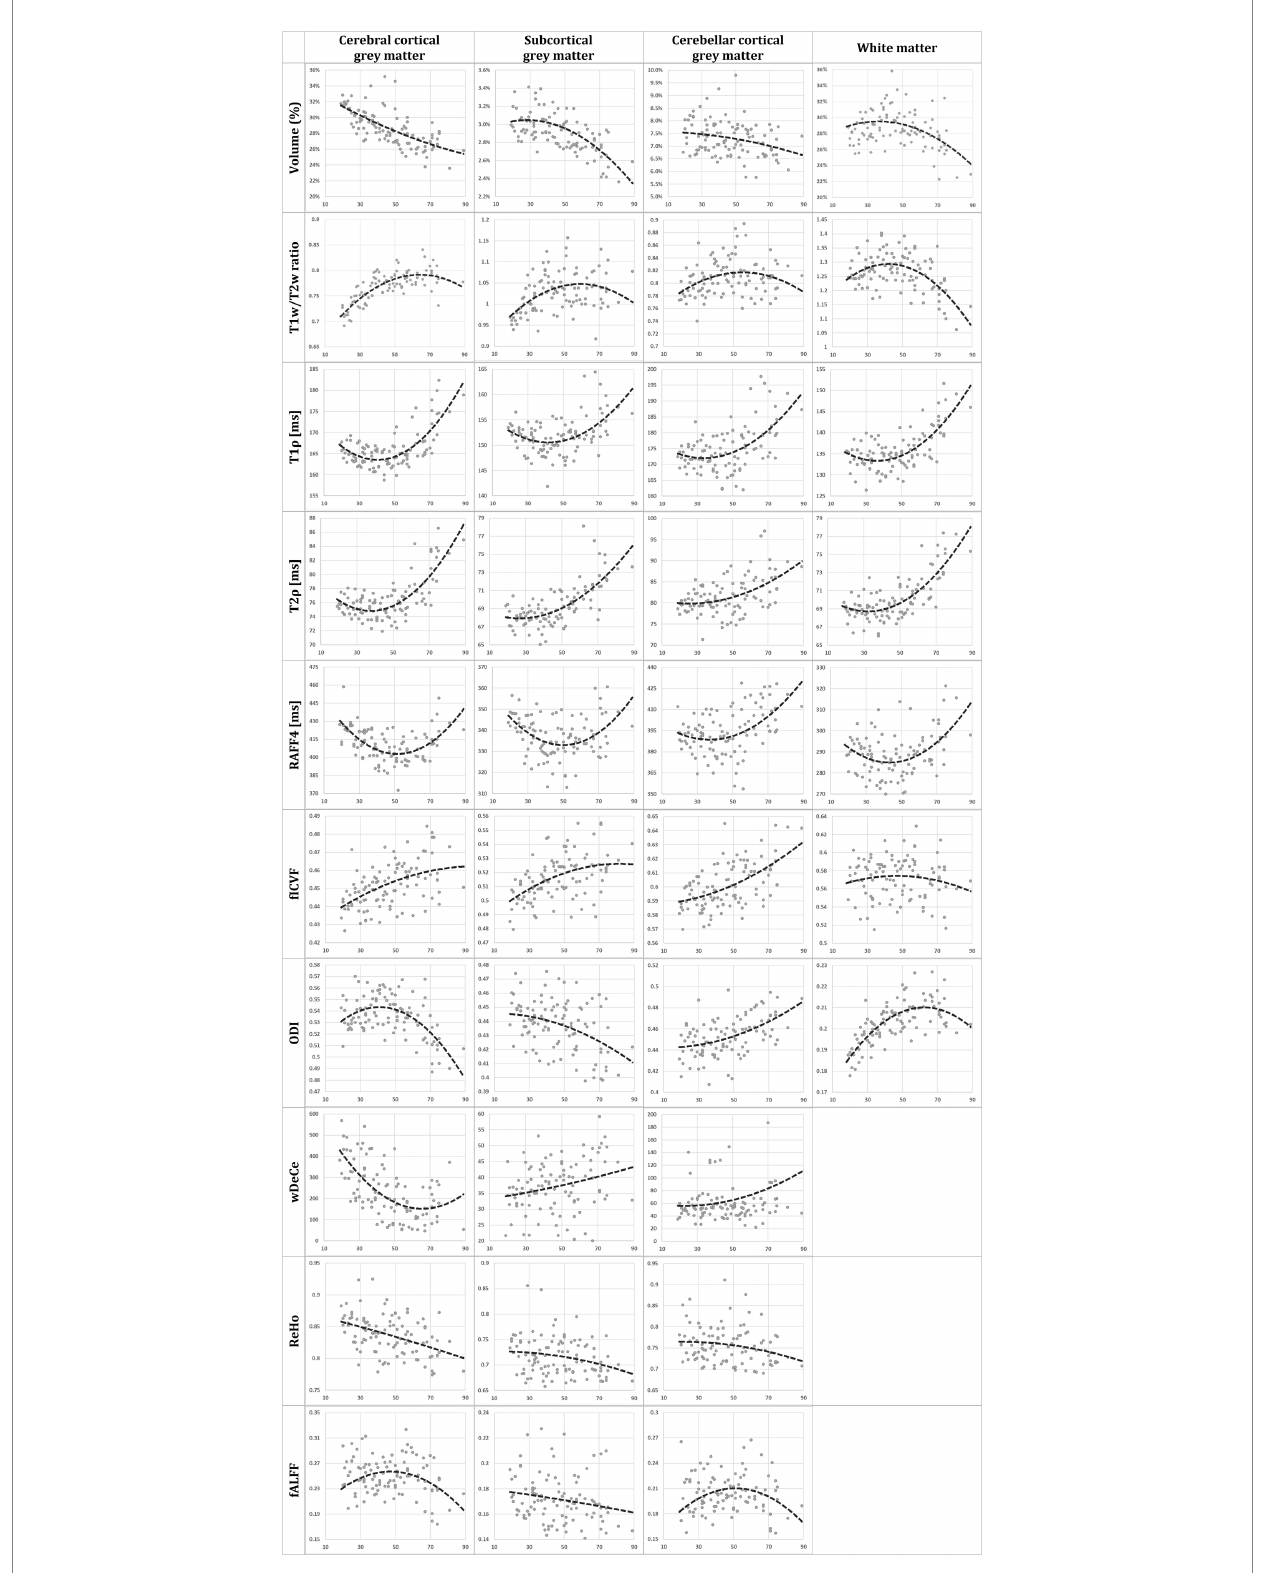
FIGURE 2 Scatterplots of age in years (axis x ) and individual MRI metrics (axis y ): normalised volume, T1w/T2w ratio, T1 ρ , T2 ρ , rank 4 Relaxation Along a Fictitious Field (RAFF4), intracellular volume fraction (fICVF), orientation dispersion index (ODI), weighted Degree Centrality (wDeCe), regional homogeneity (ReHo), and fractional amplitude of low-frequency fluctuations (fALFF), for each of the four regions of interest (cerebral cortical grey matter (GM), subcortical GM, cerebellar cortical GM and white matter [not provided for resting-state fMRI metrics]). Second order polynomial trendline is overlaid in each